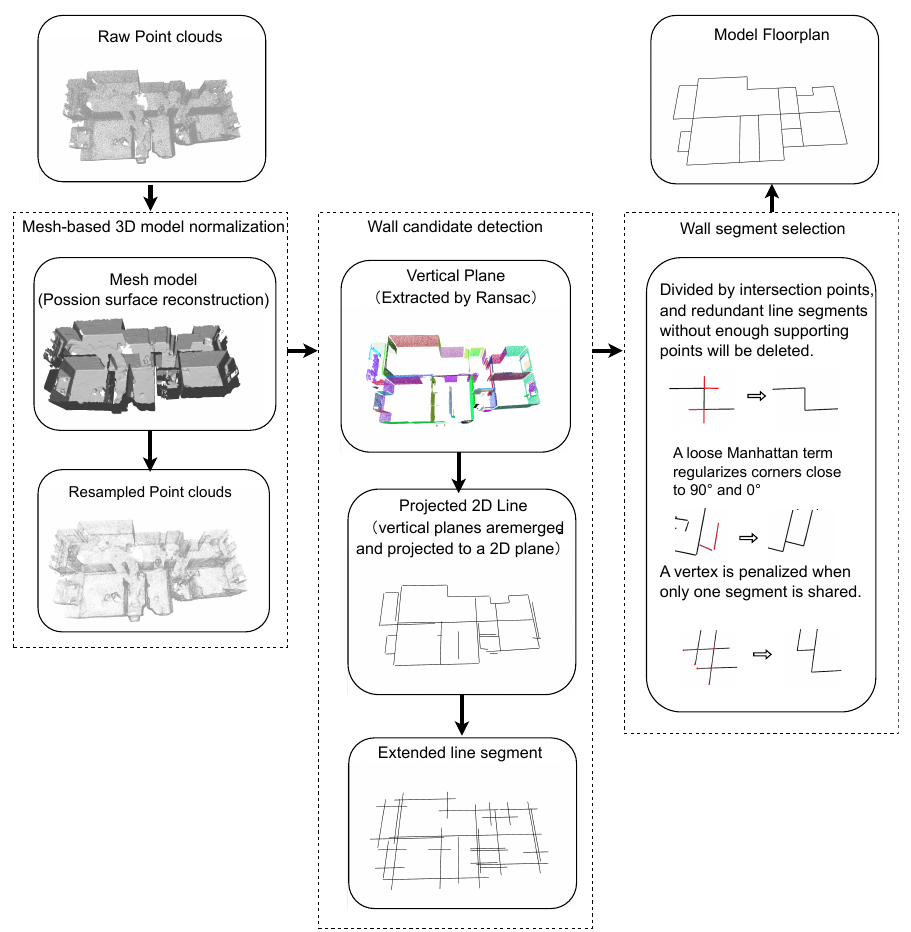
Figure 1. Overview of the proposed method. The input is a mesh model and the output is a